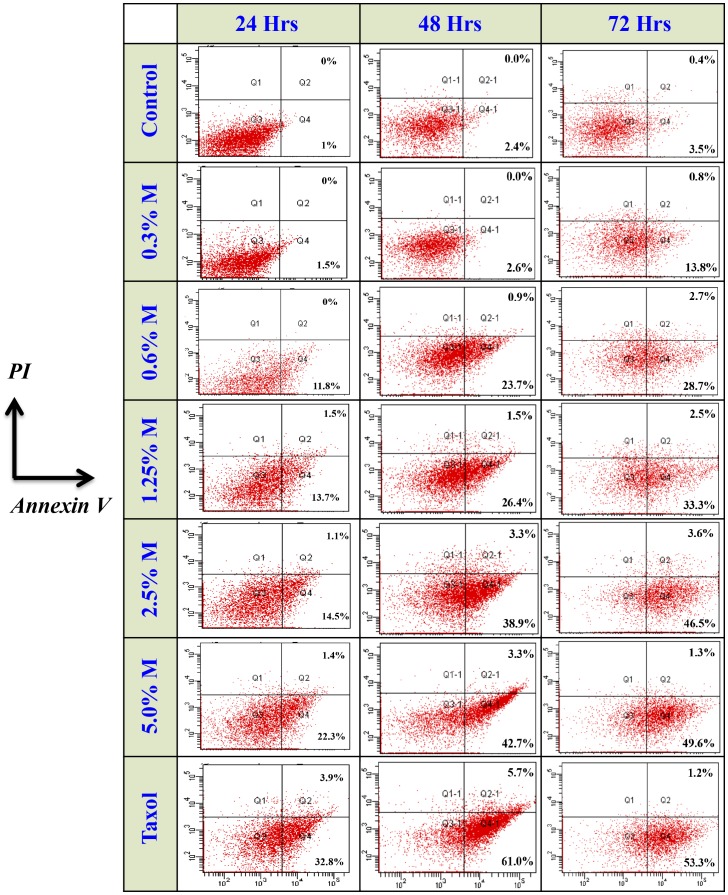
Manuka honey induces apoptosis in a dose-dependent manner.B16.F1 cells were treated for 24 hrs (left column), 48 hrs (center column) or 72 hrs (right column) with varying concentrations of manuka (M; range 0.3%–5.0%), taxol (10 ng/ml) or medium as control. At the end of the incubation period, cells were harvested and stained with Annexin V and PI, and analyzed by flowcytometry. The percentages of cells in early (Annexin V+, PI−; lower right quadrant) and late apoptotic-necrotic stages (Annexin V+, PI+; upper right quadrant) are shown. The results are representative of three independent experiments.